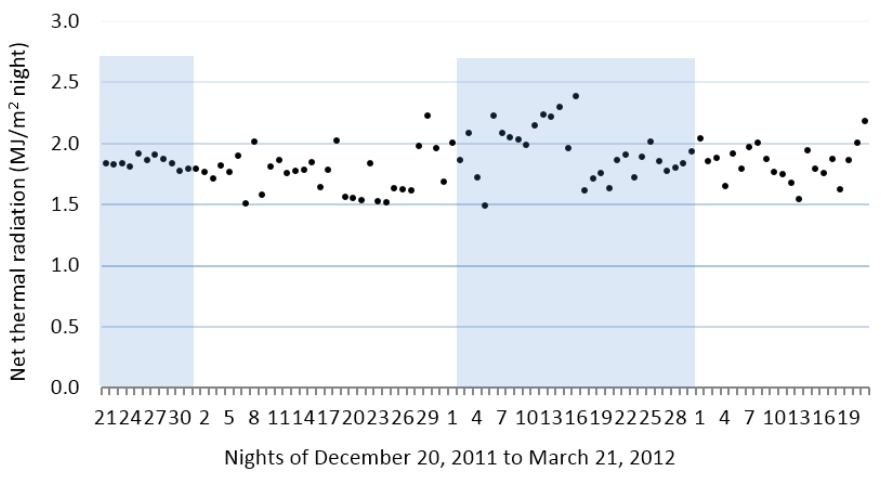
Figure 6. Night thermal radiation, calculated for the winter.